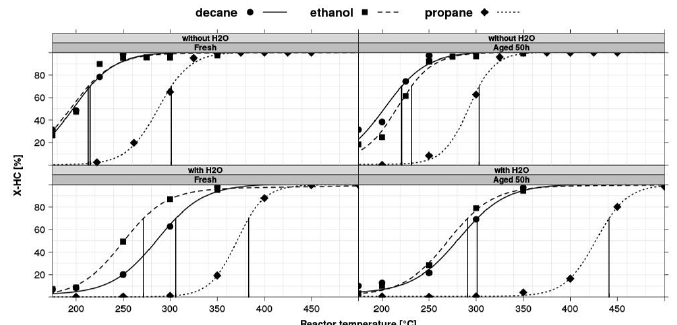
Figure 6. Light-off curves for different hydrocarbons obtained by fitting measured data points. Catalyst: 1% Pd/Al 2 O 3 prepared from Pd nitrate as the precursor.